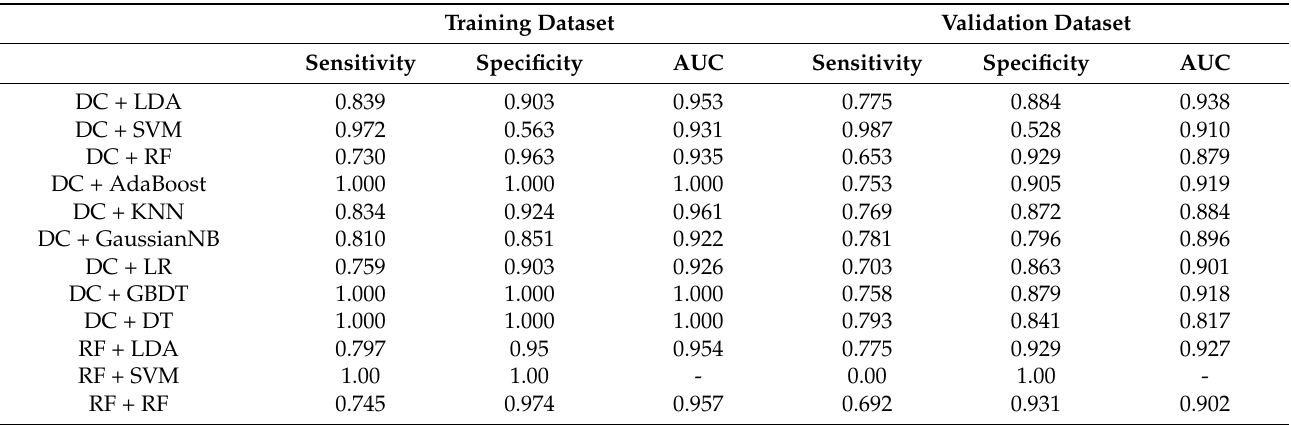
Table 2. Discriminative performance of